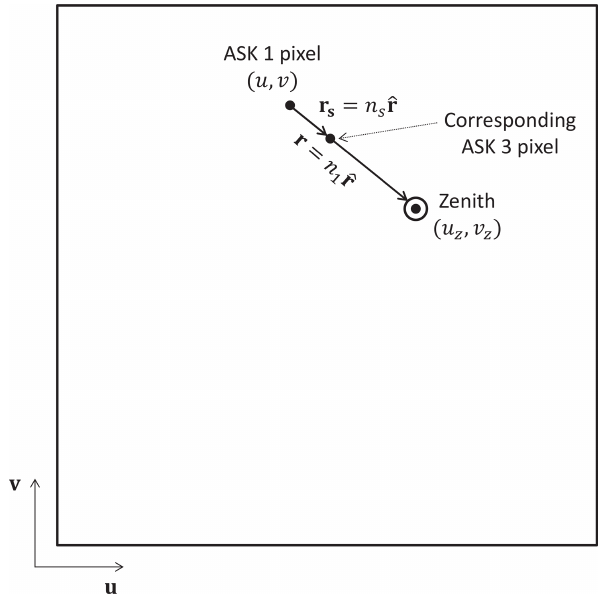
Figure 3. Geometry used to estimate perspective effects. Idealised emission rate profiles are shown on the right for ASK1 (N 2 ) and ASK3 (O).